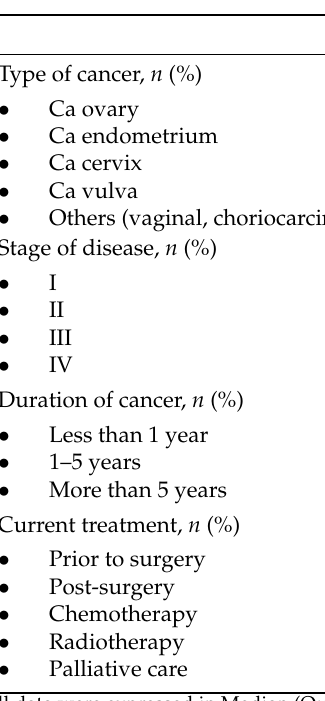
Table 2. Patient’s clinical